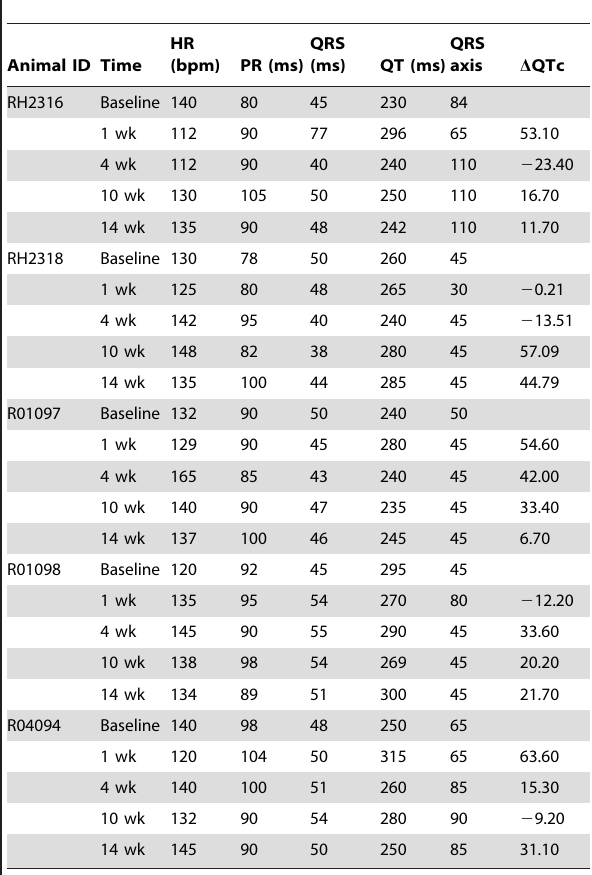
Table 3. Electrocardiogram (ECG) measurements at baseline, 1, 4, 10 and 14 weeks after 6-OHDA for each